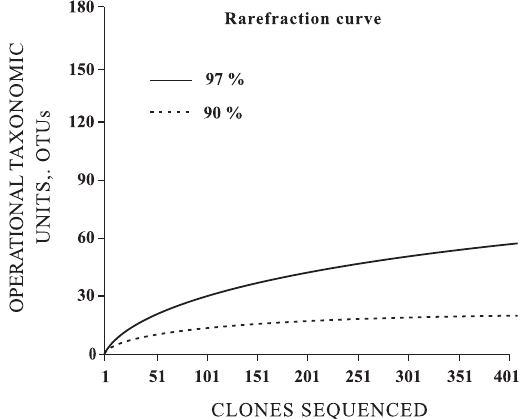
Figure 4. Rarefaction curves calculated by the DOTUR program using 97 and 90 % of similarity for grouping of the 16S rDNA sequences from the consortium clone library.